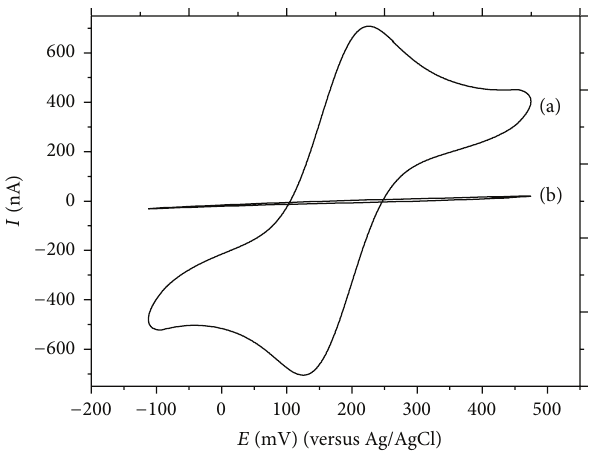
Figure 3: Cyclic voltammetry of charge transfer of ferricyanide ions on the electrode surface at bare Pt electrode (a) and Pt electrode modified with s-BLM (b) in 1.0mmol/L K 3 [Fe(CN) 6 ]/K 4 [Fe(CN) 6 ] (1: 1) mixture containing 0.1mol/L KCl. Scan rate 50 mV ⋅ s −1 .